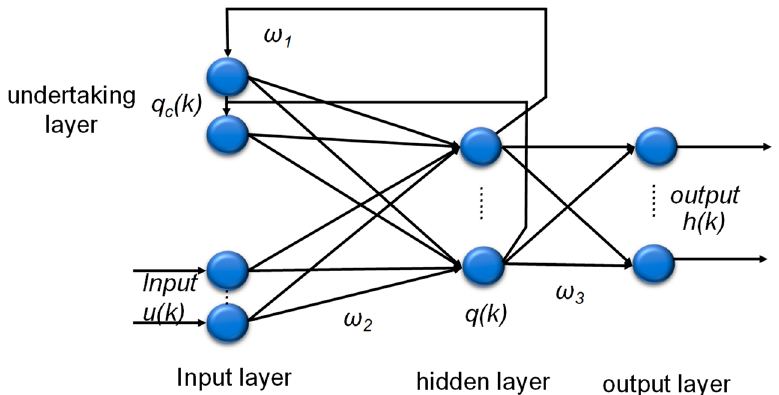
Figure 1. Structure diagram of Elman neural network. In Elman neural network model, u ( k ) is input data for neural network; q ( k ) is the output for network hidden layer; q c ( k ) is the output of the receiving layer; h ( k ) is the output of neural network, w 1 , w 2 , w 3 respectively represent the weights from the receiving layer to the hidden layer, from the input layer to the hidden layer, and from the hidden layer to the output